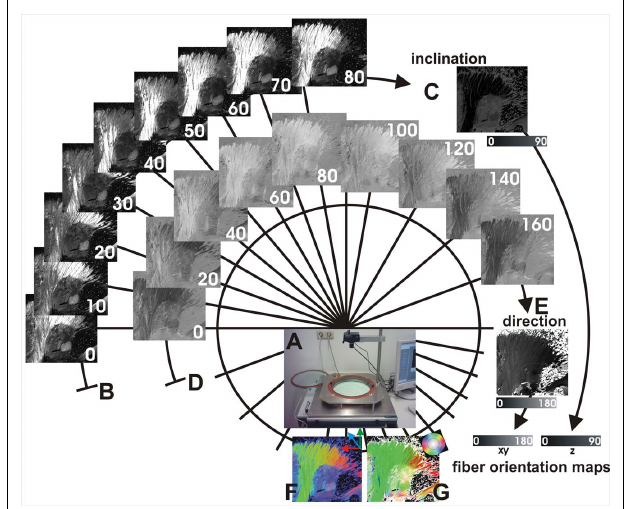
FIGURE 2 | Image acquisition and image processing of PLI. Equipment of the PLI system (A) consists of two rotatable perpendicularly oriented polarization filters and an insertable quarter-wave plate. For each section, nine images separated by 10˚ rotations of the filters using two crossed polars are acquired (B) , which are used to calculate angles of fiber inclination (C) . In addition, nine images separated by 20˚ rotations of the filters using an additionally introduced quarter-wave plate (D) are used to calculate angles of direction (E) . Angles of inclination and angles of direction in every pixel of the section define a vector representing the major 3D fiber orientation at that point. Fiber orientation maps (FOMs) can be visualized using different color schemes (F,G)